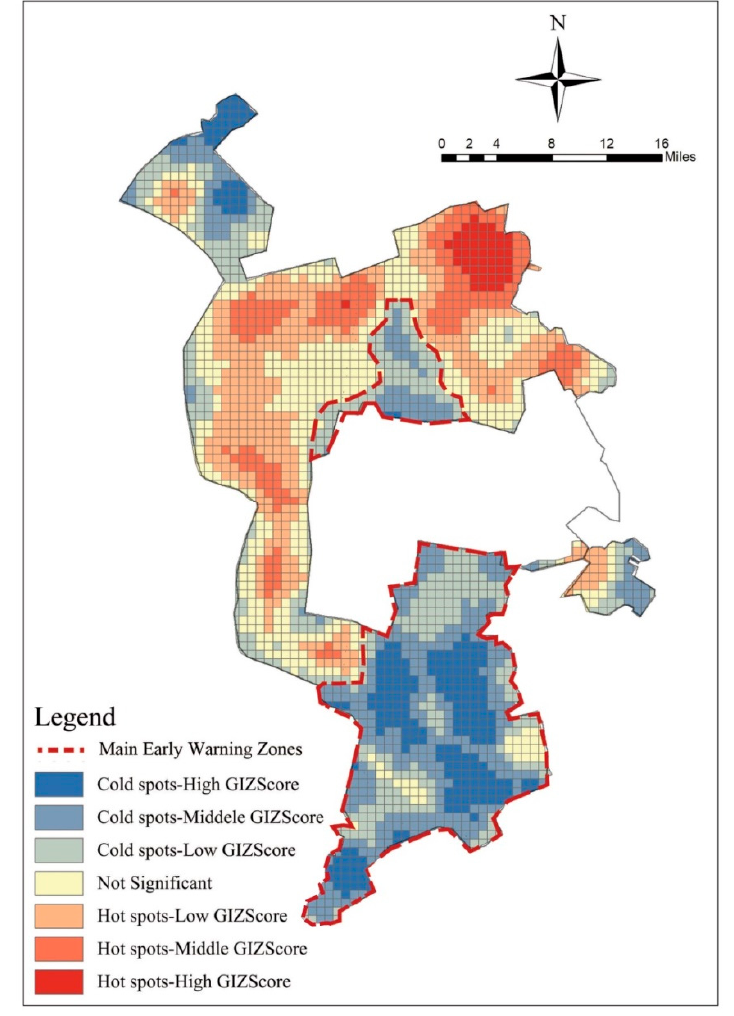
Figure 9. Change in the proportion of spatial agglomeration in the study area.